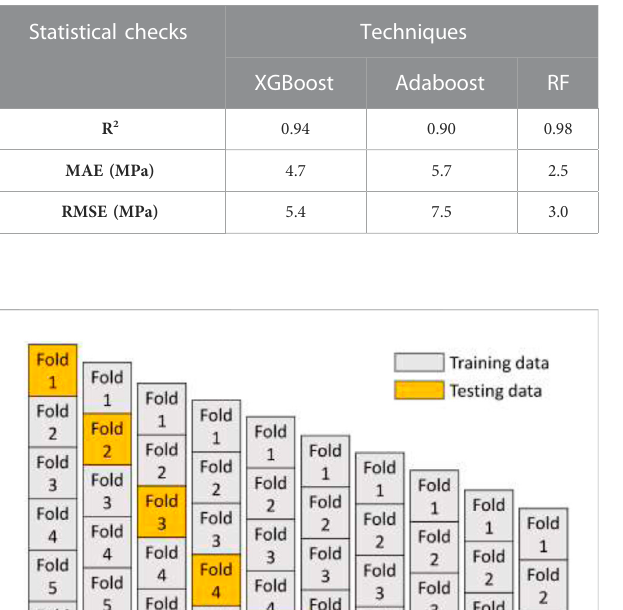
TABLE 1 Statistical analysis for XGBoost, Adaboost, and RF algorithms.